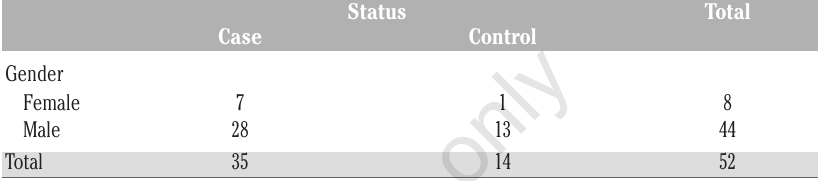
Table 1. Summary of cases and controls (bases on status in 2002) by gender.